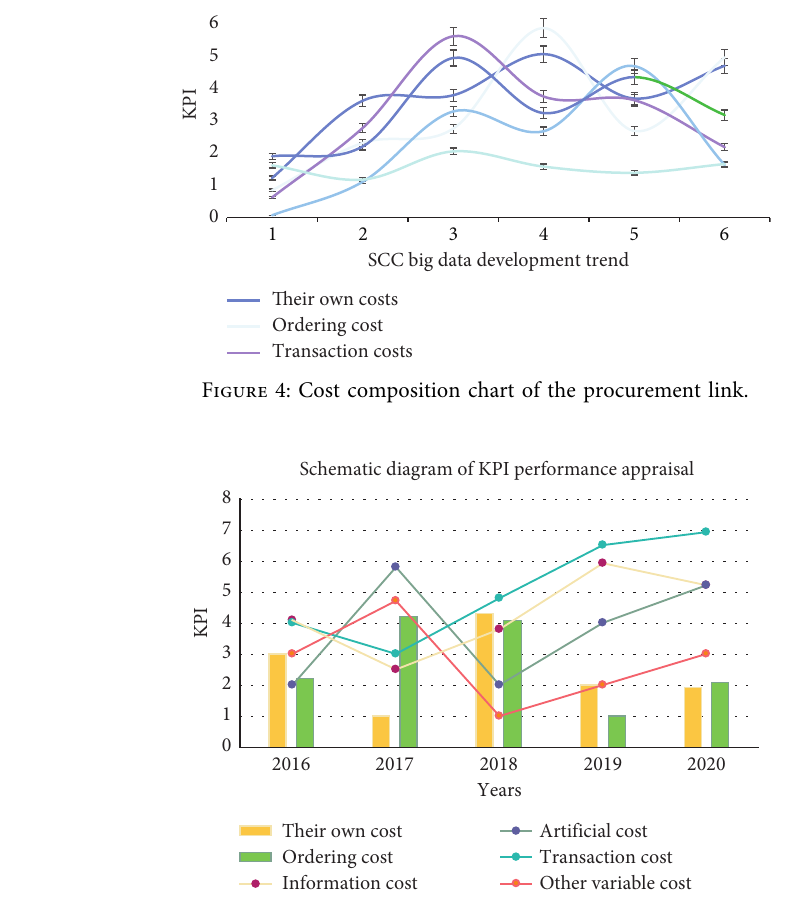
Figure 5: Schematic diagram of KPI performance